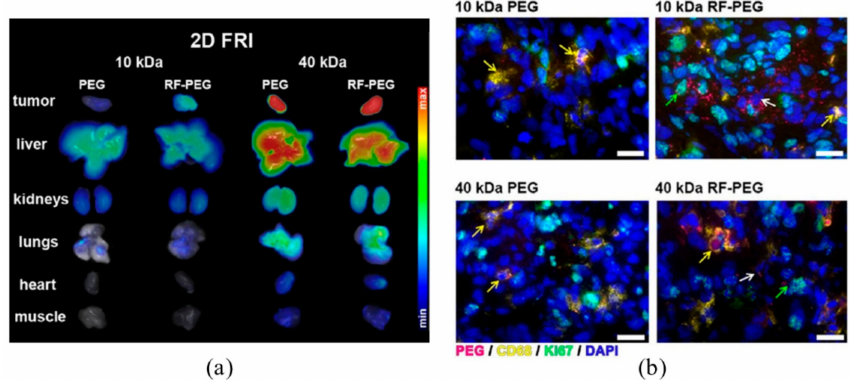
Figure 7. ( a ) Two-dimensional fluorescence reflectance images indicating PEGstar accumulation in mice bearing A431 tumors; ( b ) fluorescence microscopy images of A431 tumors showing the internalization of PEGstars. Polymers are depicted in magenta, macrophages in yellow, proliferating cells in green, and cell nuclei in blue. Adapted with permission from [81]. Copyright © 2020 American Chemical